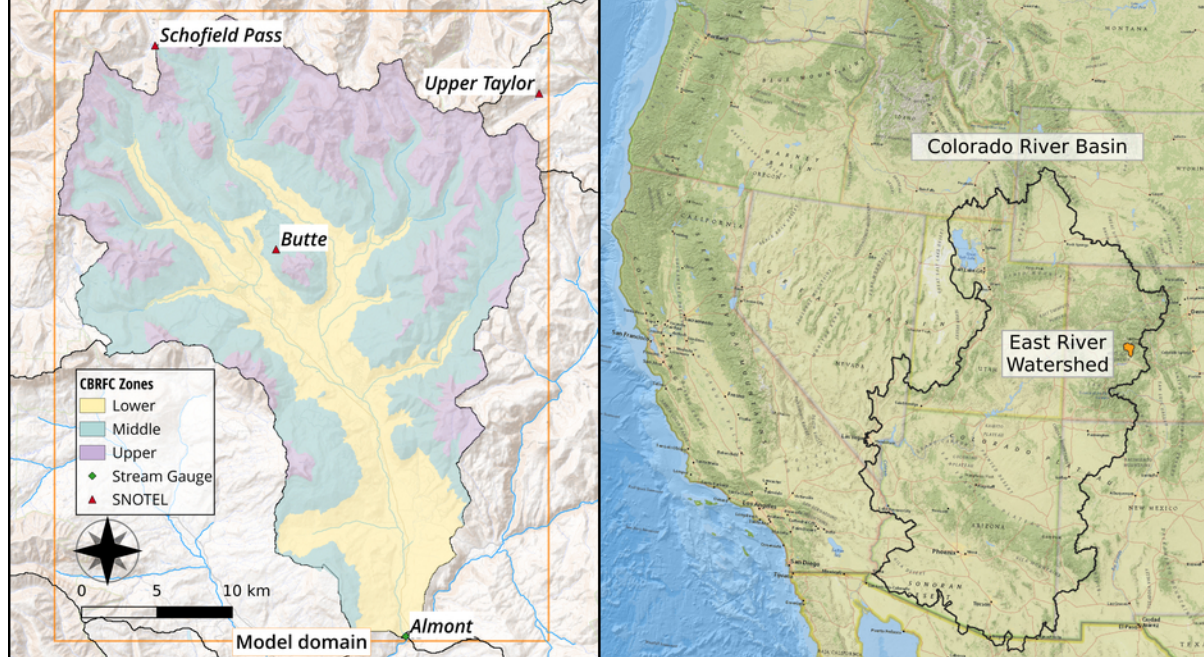
Figure 1. Overviews of the East River Watershed (black boundaries) and iSnobal modal domain (orange outline) are shown on the left. There are three SNOTEL sites along with the stream gauge station. The watershed is divided into three HRUs by the CBRFC. The location of the watershed and area of the Colorado River Basin is shown on the right. Basemap (right): © ESRI.